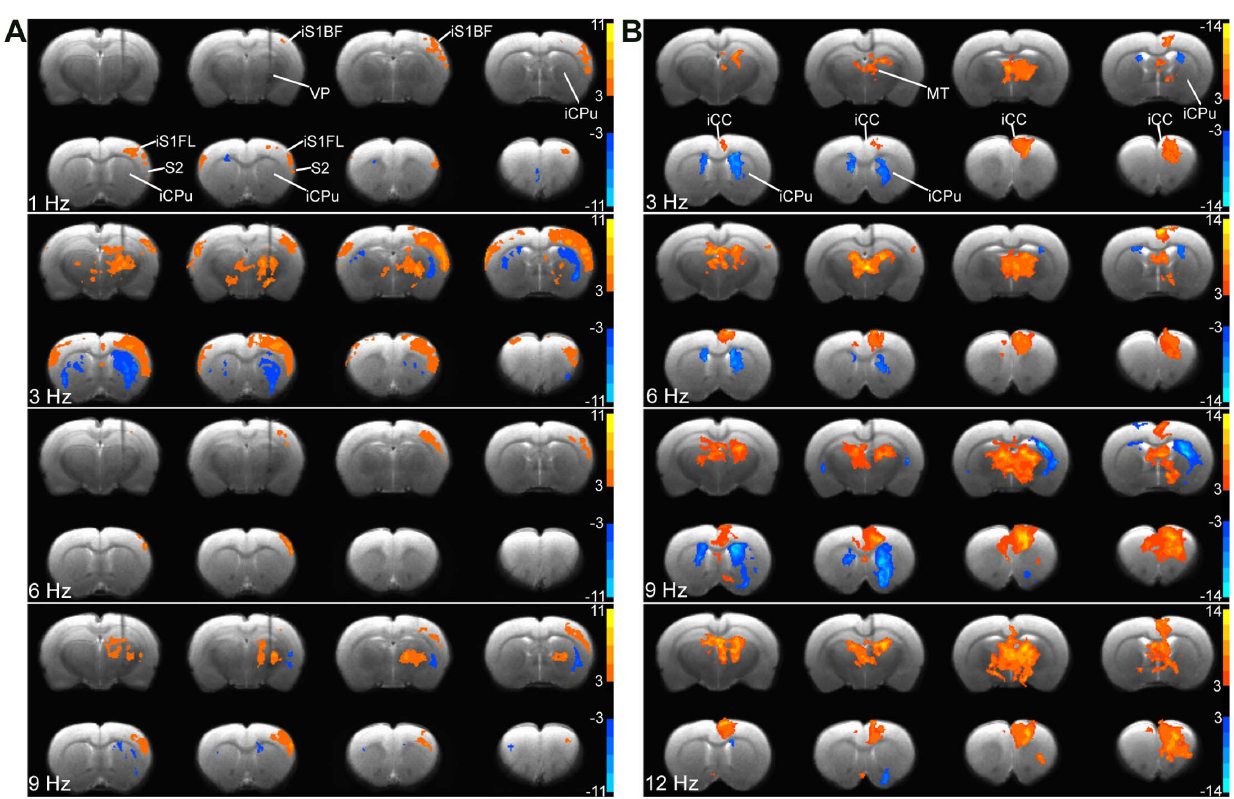
Figure 5. Frequency-dependent activity maps and region of interest analysis in the brain during VP and MT stimulation. The group activation maps evoked by VP (n=6) and MT (n=6) stimulation at various frequencies at 200 m A are shown on eight coronal sections of the forebrain in two rows from top left to lower bottom, caudal to rostral. (A) Note that VP stimulation most strongly activated BOLD responses within iS1FL at 3 Hz. (B) MT stimulation most strongly activated BOLD responses within iCC at 9 , 12 Hz. MT stimulation at 1 Hz elicited no